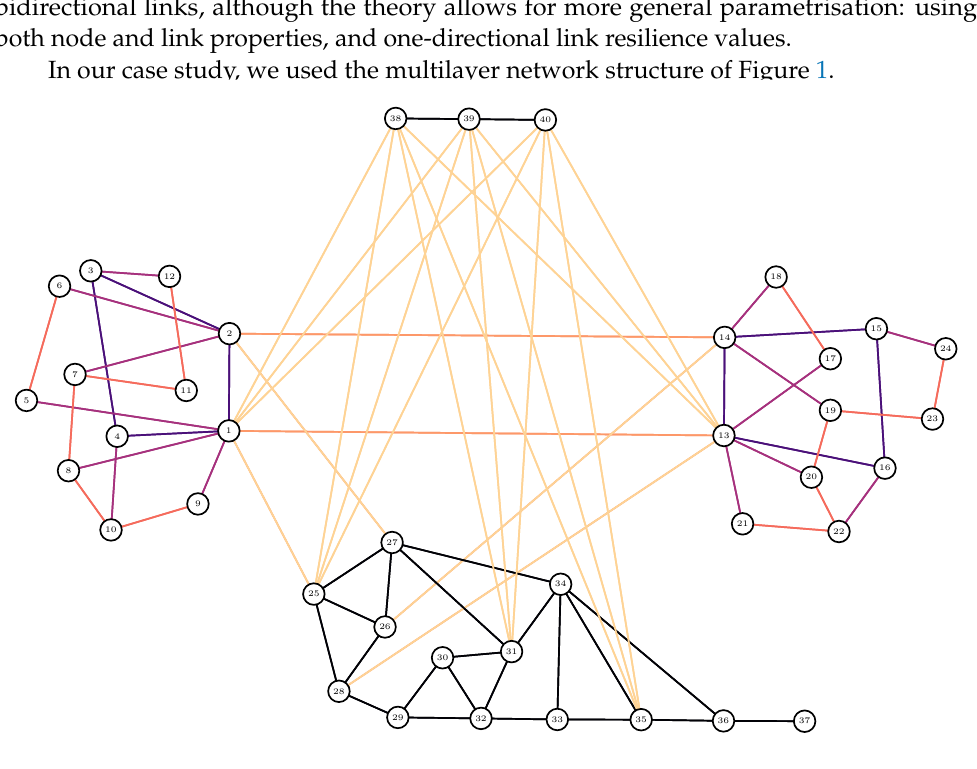
Figure 1. The structure of an exemplary multilayer communication system. The two access networks on the left and right have similar topological structures although their geographical formation may be different. A backbone network is depicted in the lower part of the figure, and a satellite system is in the upper part of the